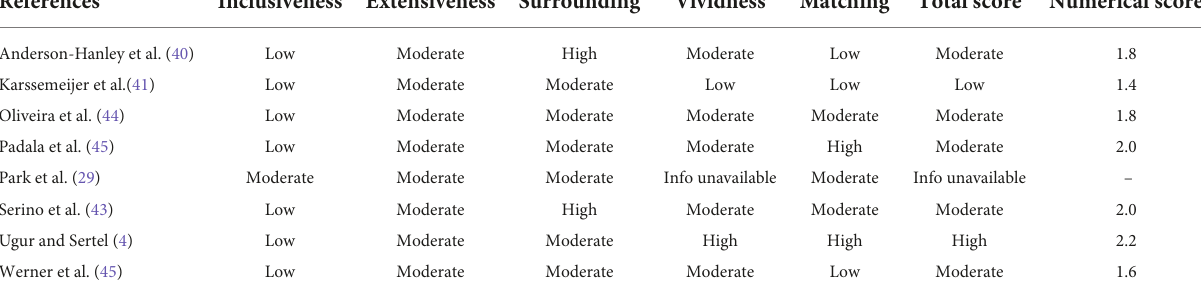
TABLE 3 Immersion levels of virtual reality (VR)